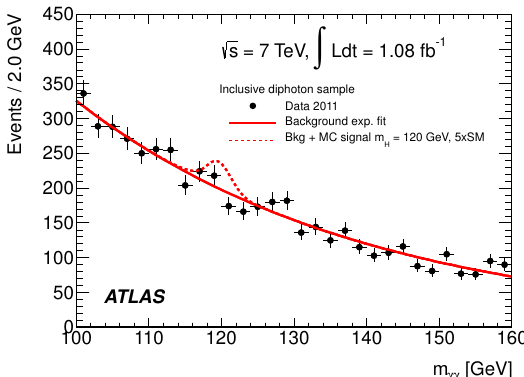
Fig. 1. Invariant mass of the diphoton candidates for the 5063 events passing the selection found in the 1 . 08 fb − 1 of ATLAS data (black dots). The background model function (defined in Section 6) is represented by the red line. Finally, five times the SM Higgs signal expectation for m H = 120 GeV is represented by the dashed red line.